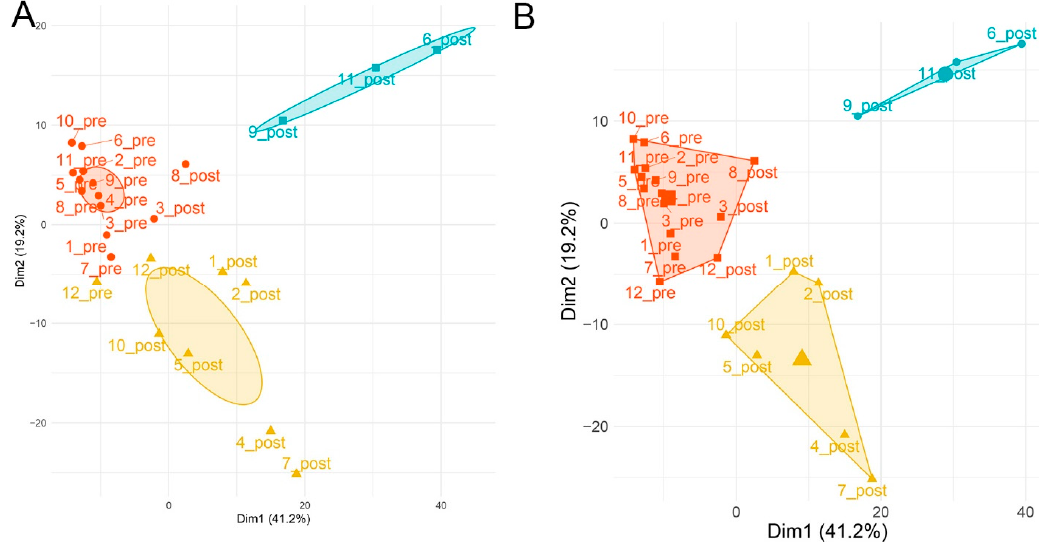
Figure 2. Global expression analysis. ( A ) Partition around medoids (PAM). The abundance of 549 significant metabolites were subjected to PAM. Subjects before challenge were grouped into one cluster (orange). After challenge, patients were grouped into two distinct clusters (clusters indicated by blue- and yellow-colored ellipses). ( B ) K-means clustering. K-means clustering of significant metabolites. The mean of each centroid is represented by the large-filled symbol. Note that SBP-Ag produces similar divergence of subjects into two classes with subject no. 12 being indeterminate.